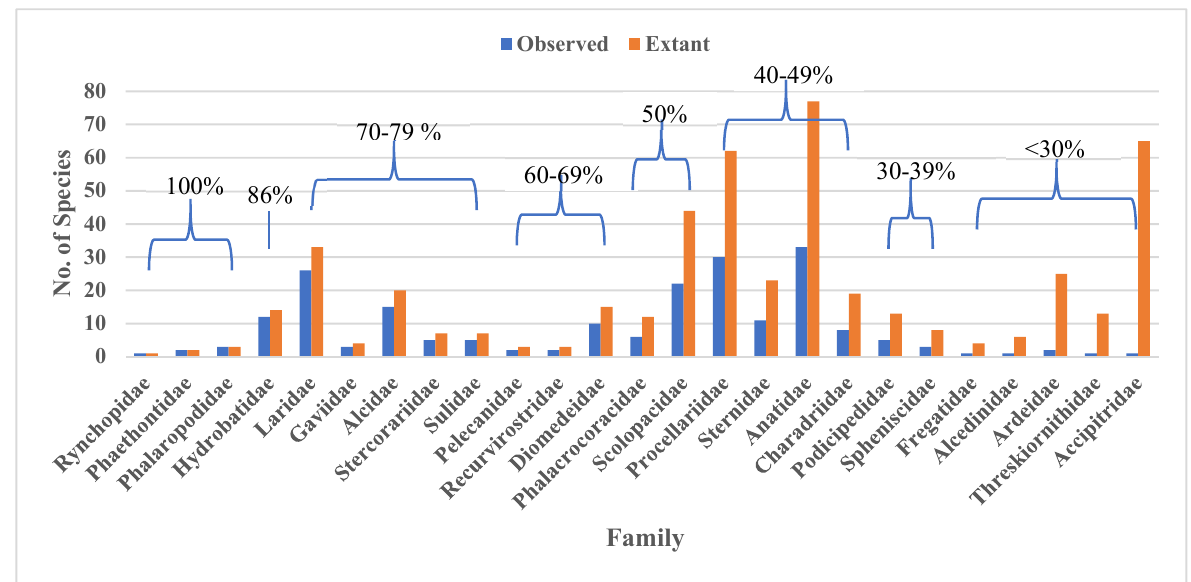
Figure 5. Number of species documented in OBIS [7] (accessed 7 August 2019) by family from 1960-2018 in the Spalding et al. [14] marine ecoregions of the Americas, plotted from highest (left) to lowest (right) percentages for each family (source of extant species data is [41]; common name equivalents can be found in Table 1). The most widely recorded family was Procellariidae (petrels and shearwaters), which was documented in 24 of the 29 ecoregions for which data were found. The Hydrobatidae (northern storm petrels, 20 ecoregions) and Laridae (seagulls, 20), and Sternidae (terns, 17), were also widely recorded. Families whose species distributions were more restricted included the cold-water Alcidae (auks, murres, and puffins in 7 ecoregions) and Sphenis- cidae (penguins, 2). Families with species found in freshwater as well as marine environ- ments, or that typically occur nearshore, included Anatidae and Gaviidae (ducks and geese, 6 species, and loons at 6), Podicipedidae (grebes, 5), Alcedinidae (kingfishers, 3), Recurvirostridae (stilts and avocets, 2), Rynchopidae (skimmers, 2), Threskiornithidae (ibises and spoonbills, 2), and Accipitridae (ospreys, 1) (Table 1). In eleven South American ecoregions for which observations were recorded in OBIS [7], occurrence records for fewer than six families were found (Table 1), though all eleven ecoregions contained records for the family Diomedeidae (albatrosses). In contrast, in sev- eral North American ecoregions, the majority of species for each family were documented. Representatives of 63% of all avian families found in the study were recorded in the “Cold, Temperate Northeast Pacific” province, and more than half of the species of those families were recorded within the Puget Trough/Georgia Basin ecoregion. In the “Cold, Temperate Northwest Atlantic” province, representatives of 67% of the families were recorded the Gulf of Maine/Bay of Fundy ecoregion, 73% in the Virginian ecoregion and 81% in the Carolinian ecoregion. 4. Discussion